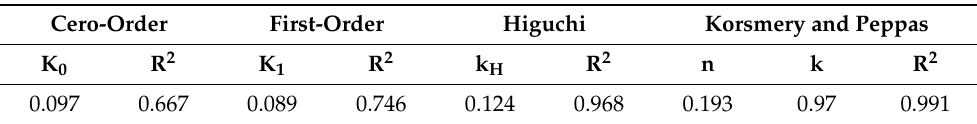
Table 2. Constants and regression coefficients for models applied to the release profile in chitosan- thyme nanocapsules.